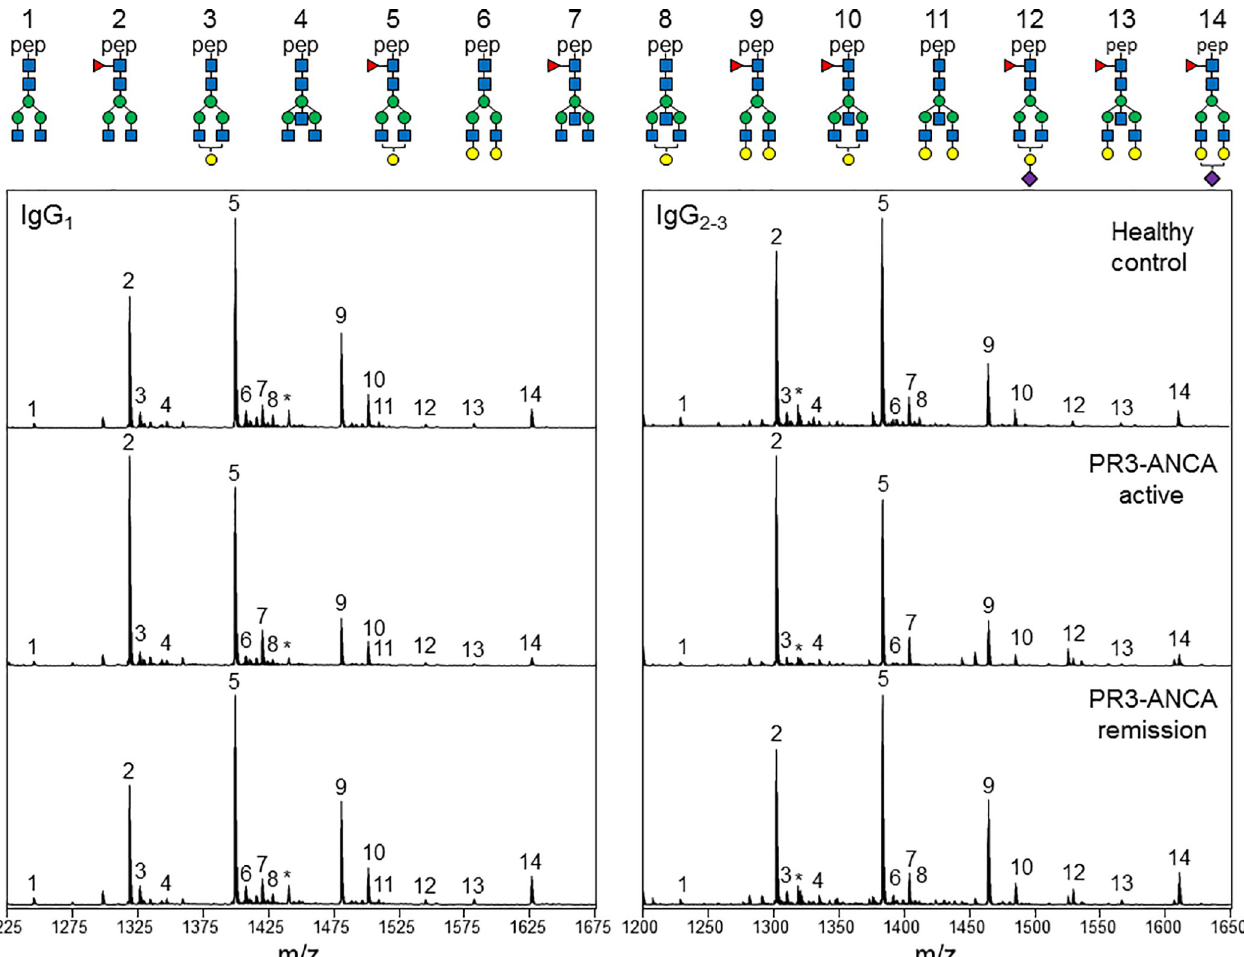
Fig 2. ESI-QTOF-MS spectra of total plasma IgG Fc N -glycopeptides. Representative LC-MS signals of the doubly protonated glycopeptide species are shown for a healthy control (top panels), a PR3-ANCA patient in active phase (middle panels), and the same patient in remission (bottom panels). Structures of the most abundant glycoforms detected in the present study are depicted above the upper panels with the numbers corresponding to the respective peaks on each MS spectra. Pep: peptide moiety, blue square: N -acetyl glucosamine, red triangle: fucose, green circle: mannose, yellow circle: galactose, purple diamond: N -acetyl neuraminic acid (sialic acid), � : contaminant or irrelevant peak.